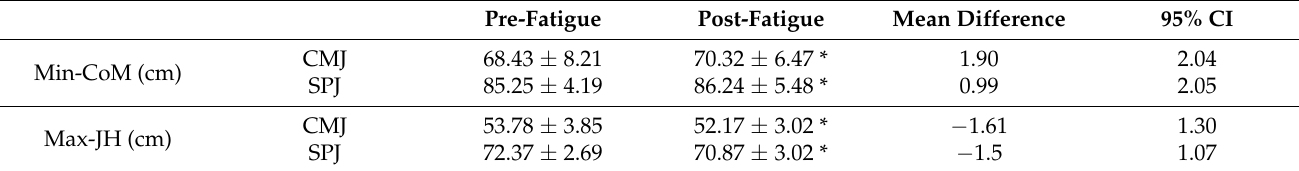
Table 1. The lowest point of the CoM (Min-CoM) and the maximum jump height (Max-JH). Pre-Fatigue